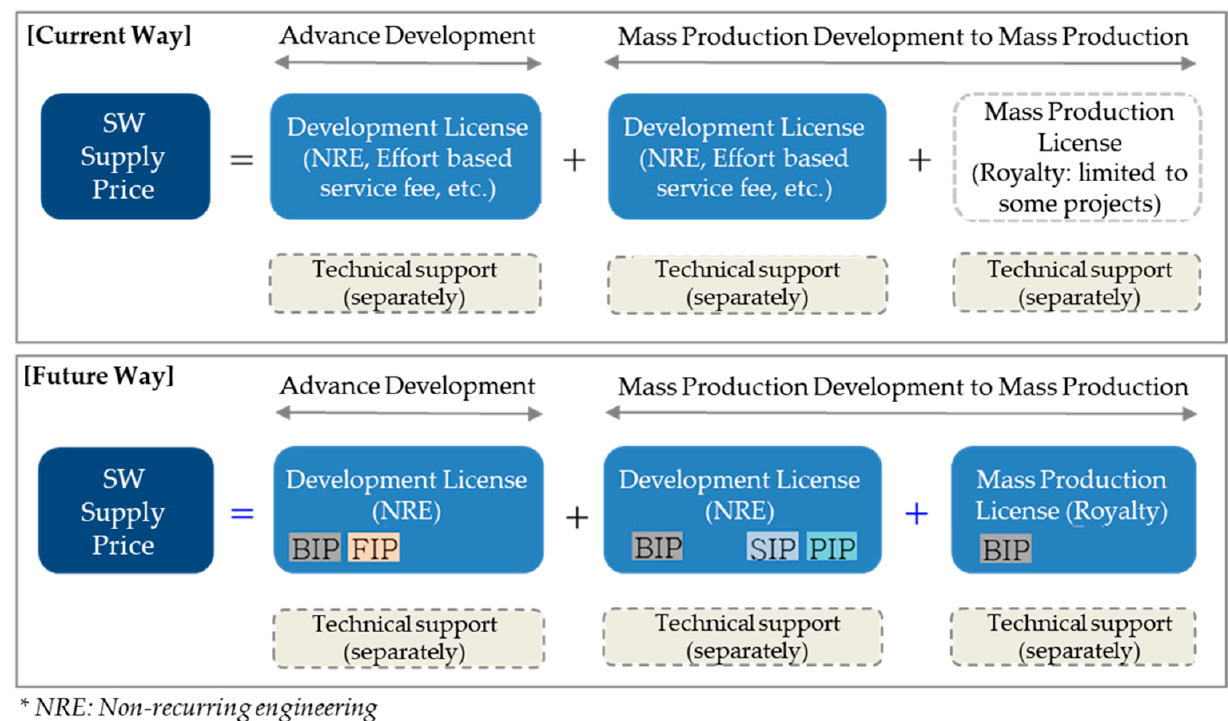
Figure 9. Software module unit supply concept.